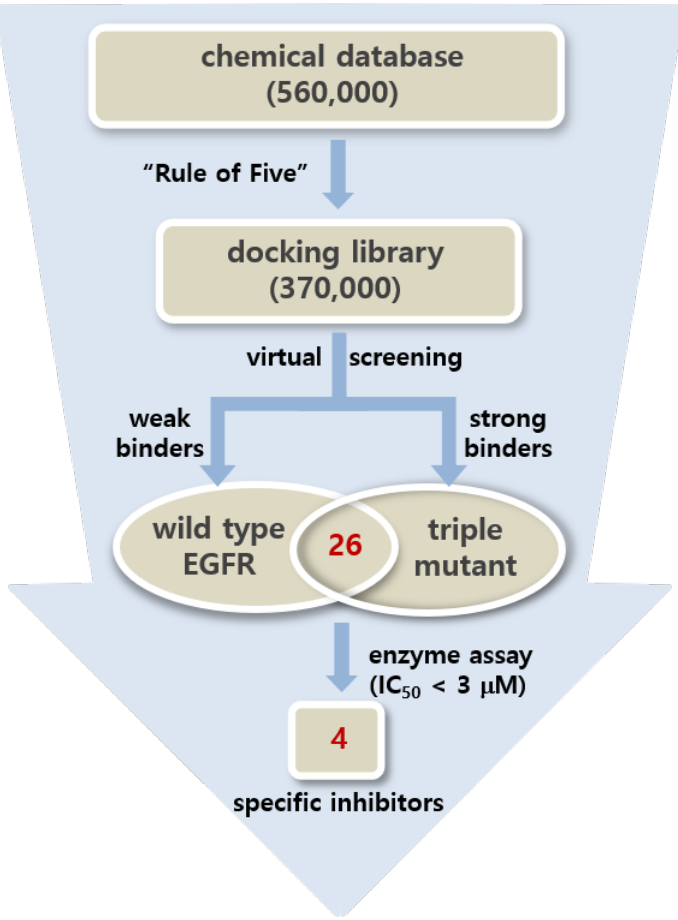
Figure 2. Flowchart for the discovery of the fourth-generation epidermal growth factor receptor (EGFR) inhibitors specific for the d746-750/T790M/C797S mutant using the two-track virtual screening and enzyme inhibition assays.